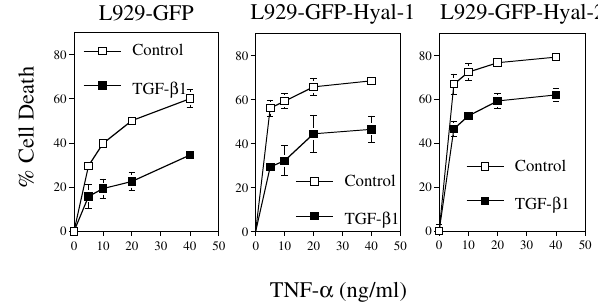
Figure 7 TGF- β 1 suppresses Hyal-1 and Hyal-2-increased TNF cyto- toxicity in L929 cells. L929 cells stably expressing GFP, GFP- Hyal-1 or GFP-Hyal-2 were cultured in 96-well plates over- night, treated with TGF- β 1 (2 ng/ml) for 2 hr, and then cotreated with TNF- α (5–40 ng/ml) for 24 hr. TGF- β 1 inhib-